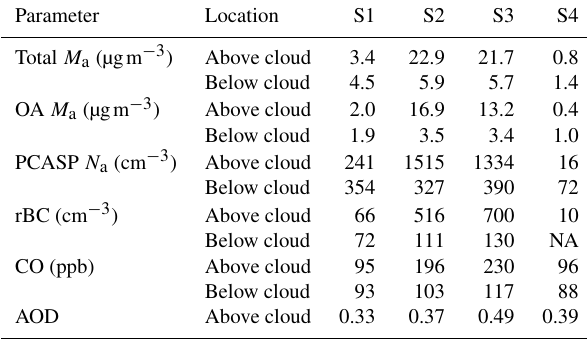
Figure 4. Snapshots of the boundary layer sampled below (a) S1 showing shallow cumulus and stratocumulus layers with varying bases, and (b) S4 showing stratocumulus clouds with a uniform base (NSRC/NASA Airborne Science